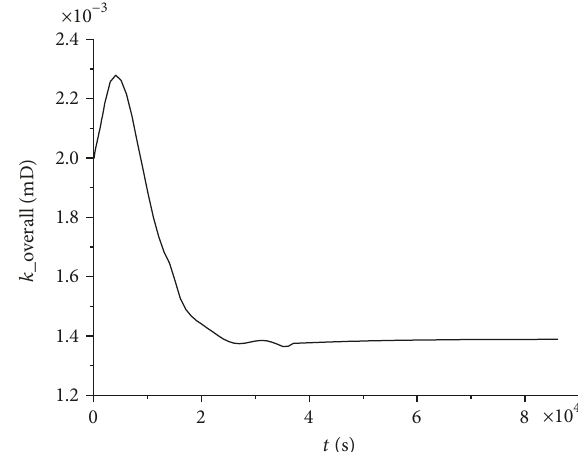
Figure 13: The evolution of overall permeability with